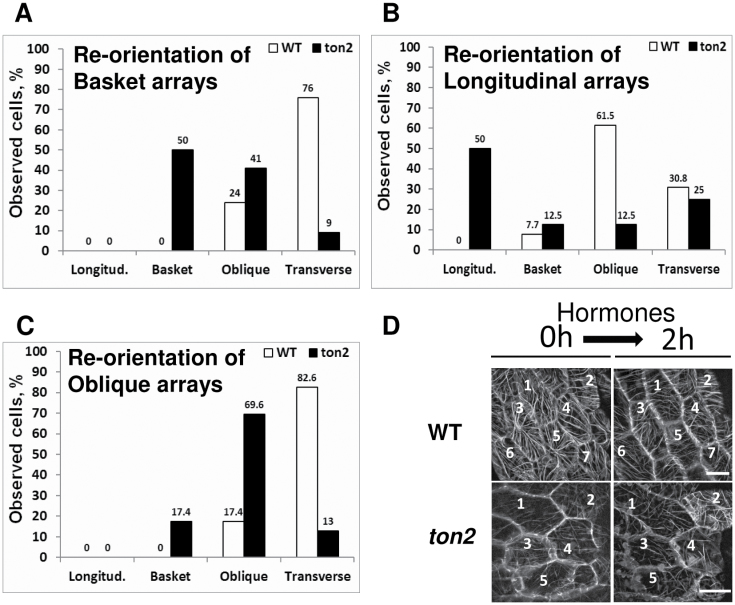
Microtubule array orientation in wild-type and ton2 hypocotyl cells after 2h of hormone treatment starting from different configurations. (A) All (100%) of basket arrays in wild type (WT) and 50% of basket arrays in the ton2 mutant were reoriented during 2h hormone treatment into oblique and transverse microtubule arrays. Half of the ton2 basket arrays did not reorient. No basket arrays became longitudinal. (B) Longitudinal arrays of wild type and ton2 reoriented (100% in wild type and 50% in the ton2 mutant) into basket, oblique and transverse configurations; 50% of ton2 longitudinal microtubule arrays did not reorient. (C) Oblique arrays were reoriented into basket (in the ton2 mutant only) or transverse configurations; 17% of wild type and 69.6% of ton2 arrays did not reorient. (D) Examples of microtubule array configurations before and after hormone treatment. Microtubule configurations of individual cells were recorded before and after 2h of hormone treatment. Bar=10 µm; 5 different plants were analysed with 17 wild type-cell and 22 ton2 cells in initial basket configuration, 13 wild-type and 8 ton2 cells in initial longitudinal configuration, 23 wild-type and 23 ton2 cells in initial oblique configuration.